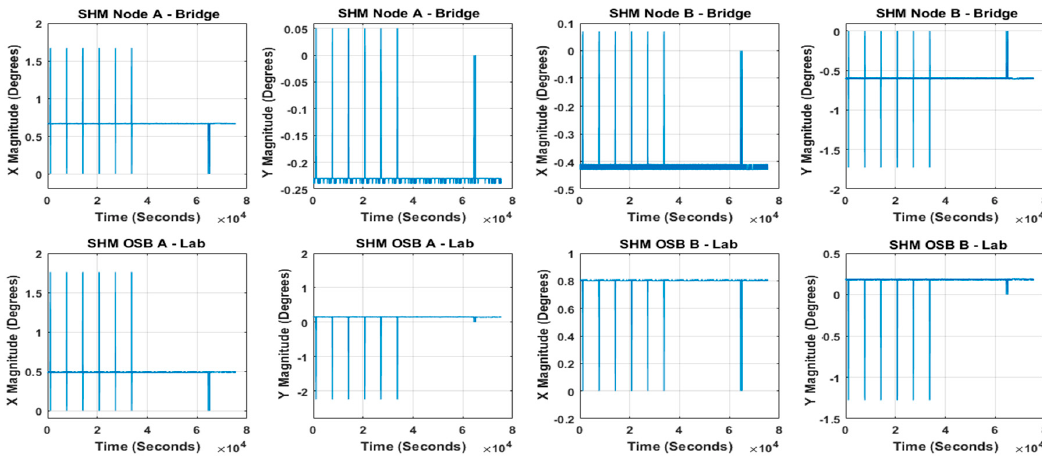
Figure 16. Bi-axial tilt angles data gathered at two unique geolocations in five calendar months (80,000 samples).